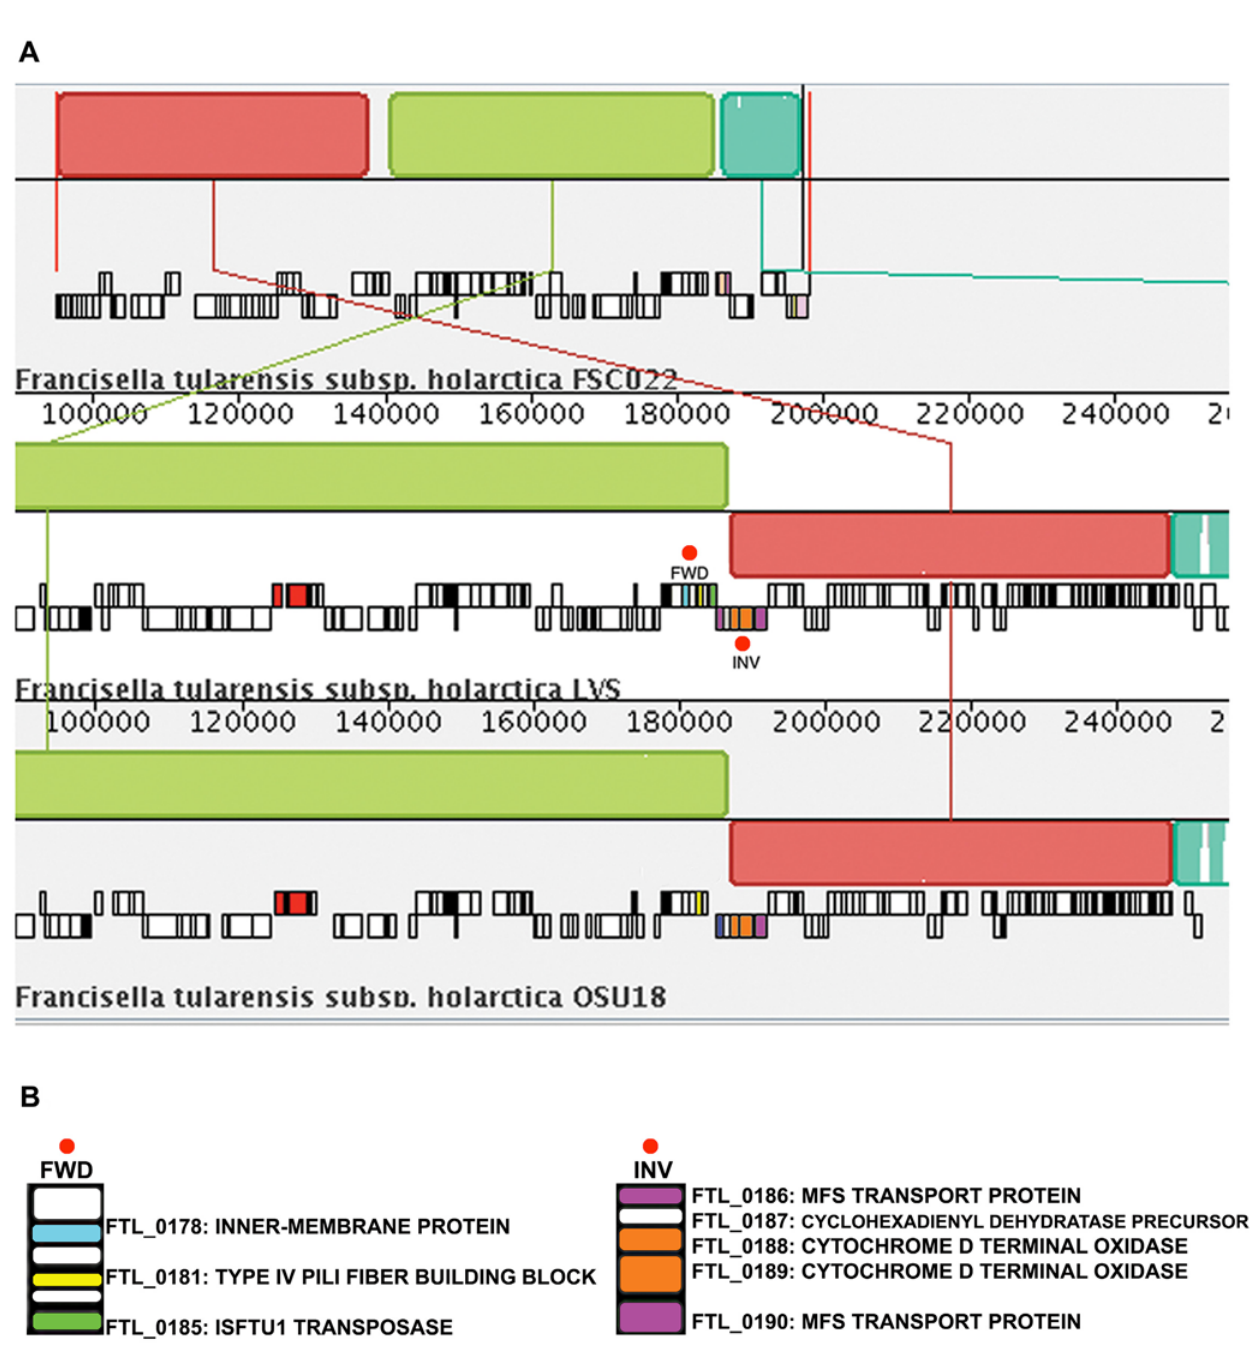
Figure 4. Multiple alignment of Francisella genomes of the Type B lineage identifies conserved sequence regions with rearrangements; pseudogenes are found proximal to predicted breakpoints. A comparison of genome rearrangement patterns between the more ancestral F. tularensis subsp. holarctica FSC022 japonica strain and representative strains of the main holarctica group ( F. tularensis subsp. holarctica LVS and F. tularensis subsp. holarctica OSU18) was done using MAUVE (A). MAUVE uses an anchored alignment algorithm that permits reordering of the alignment anchors for identification of rearrangements. Colored Local Collinear Blocks (LCBs) are regions of sequence alignment that are free of rearrangements. Each LCB is defined by the anchor regions or predicted sites of rearrangement. A default LCB cutoff of 175, and a filtering for larger blocks containing 10 Kb or larger was done in Mauve. Sequence inversions are denoted by differential positioning of the LCBs relative to a reference axis. A zoomed-in section of the whole-genome alignment is shown so that the annotated ORFs are visible (black outlined boxes). The small red ORFs are rRNA genes. ORFs proximal to predicted rearrangement breakpoints (red circles) have been color coded and labeled (FWD, INV). A summary of the predicted protein products for these genes is provided in (B). These include genes that have been identified as being either disrupted or absent in the F. tularensis subsp. holarctica subspecies.